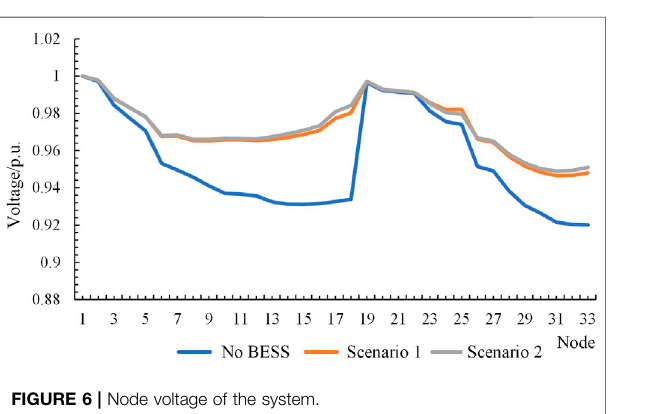
FIGURE 8 | Optimization scheduling results of Scenario